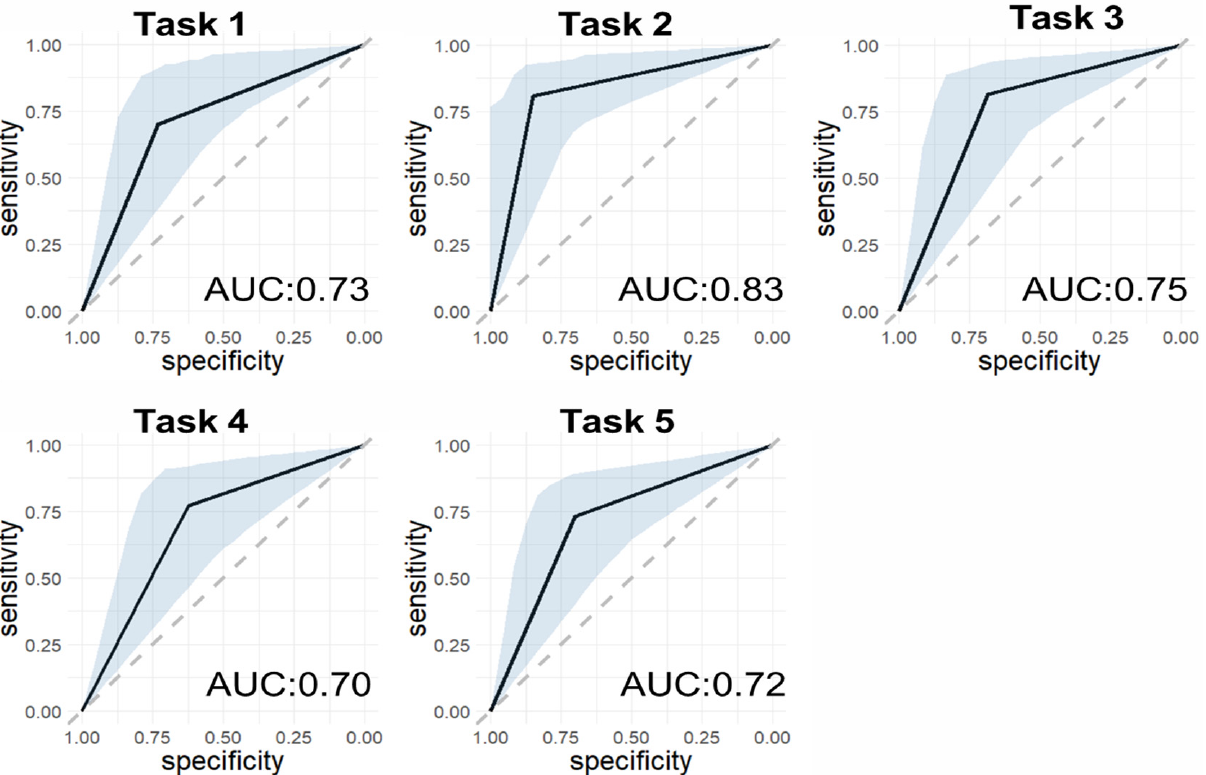
Figure 2. Receiver Operating Characteristic (ROC) curve (solid black line), empirical 95% confidence interval (grey shade), and area under the ROC curve (AUC) of the image-derived Luria-Nebraska Neuropsychological Battery (LNNB) tasks, classifying participants with lower mobility (LNNB score < population mean levels). Dashed grey line indicates the line of no-discrimination. Task 1: the dominant hand clench, Task2: the finger–thumb touching with the dominant hand, Task 3: the non-dominant hand clench, Task 4: the finger–thumb touching with non-dominant hand, Task 5 alternative hand clench.